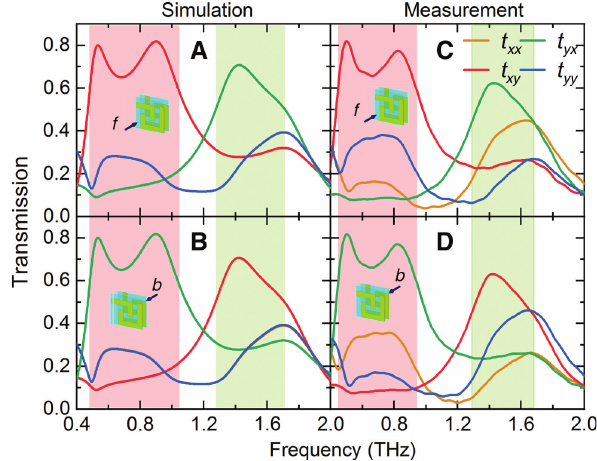
Figure 2: The results of simulation and measurement. Simulated (A), (B) and measured (C), (D) spectra of the four transmission coefficients along the forward (A), (C) and backward (B), (D) propagations. Curves t Figure 2A and